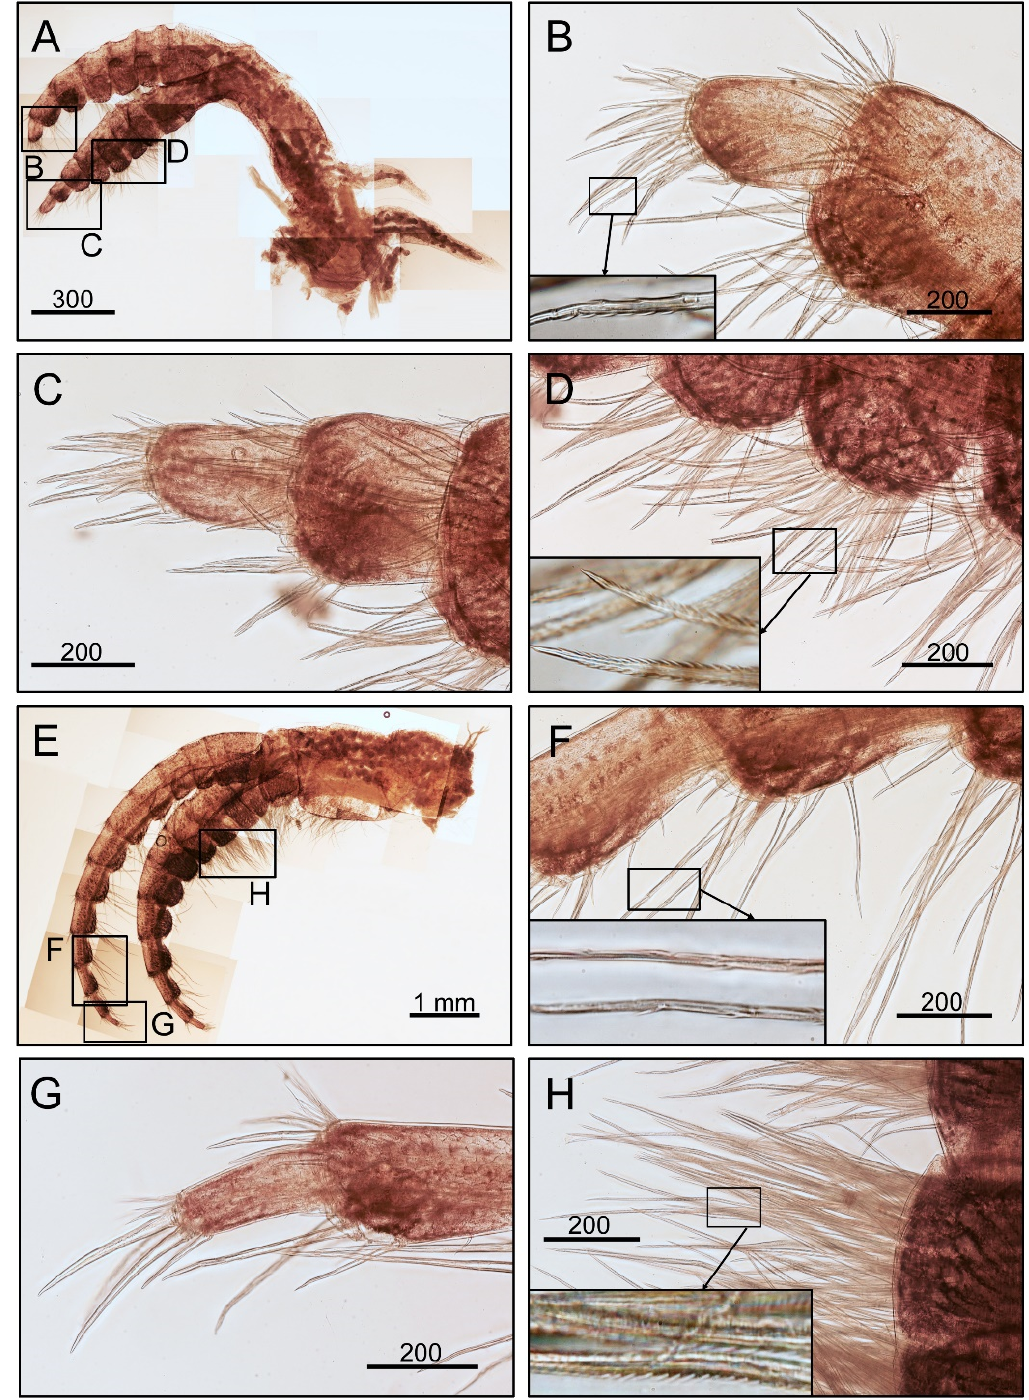
Figure 7. Conchoderma hunteri . ( A ) Cirrus I, showing two filamentary appendages at base region. ( B ) Posterior ramus, showing serrulate setae. ( C ) Anterior ramus, showing serrulate setae. ( D ) Protuberant segment of cirrus I, showing serrulate setae. ( E ) Cirrus II. ( F ) Posterior ramus showing serrulate setae. ( G ) Anterior ramus, showing serrulate setae. ( H ) Intermediate segment of anterior ramus, showing serrulate setae. Scale bars in μ m.